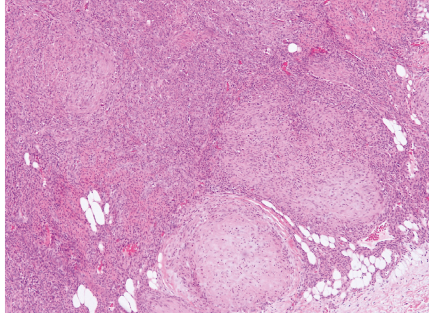
Figure 5: Higher power view (10x magnification) shows a mul- tinodular, biphasic tumor with alternating hyper and hypocellular areas.